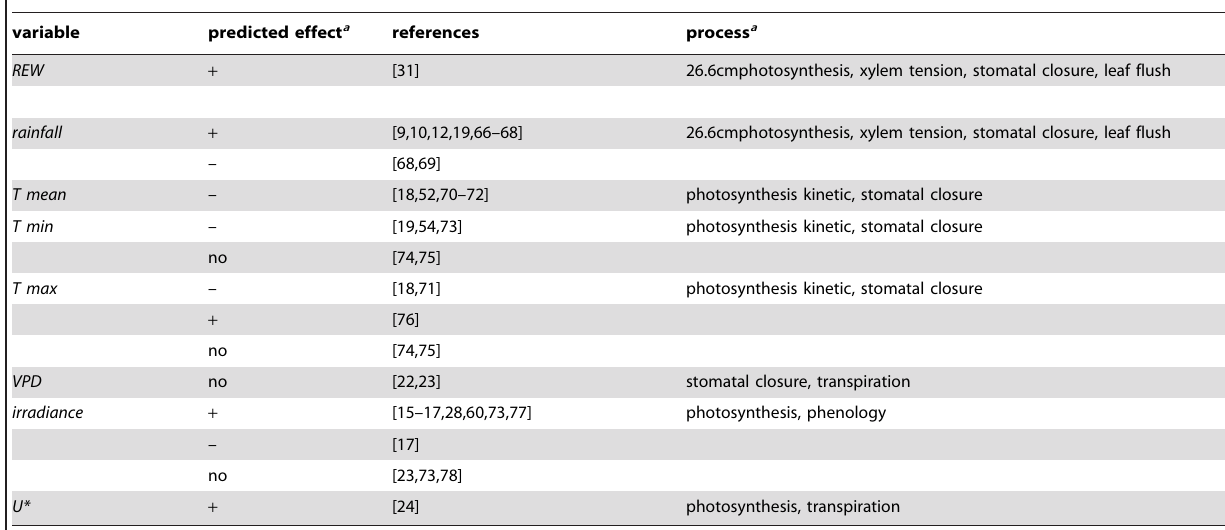
Table 1. Expected tree growth response to climate